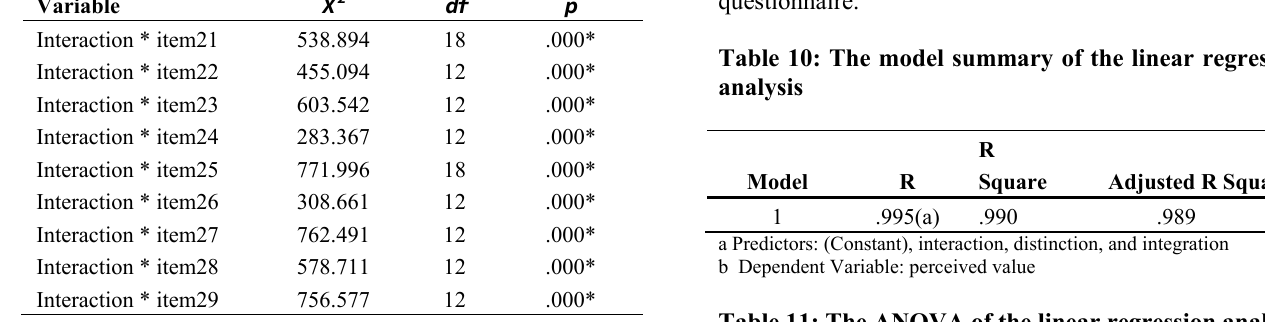
Table 11: The ANOVA of the linear regression analysis